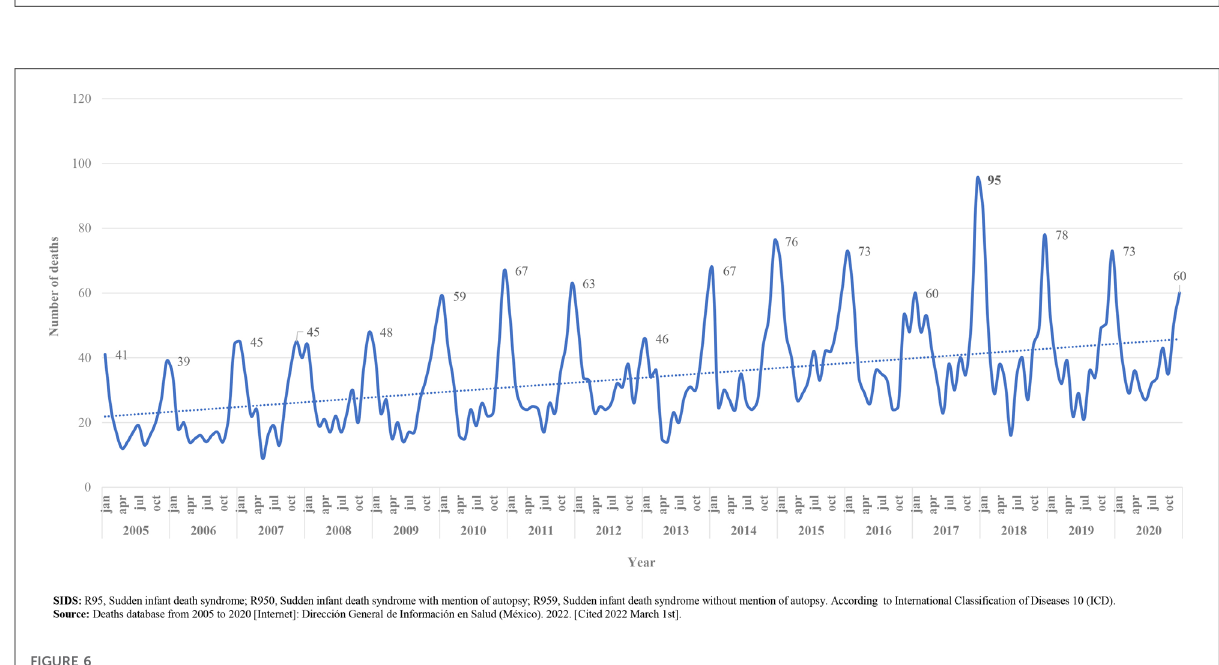
FIGURE 6 Deaths due to SIDS, monthly variation, 2005 – 2020. Mexico.